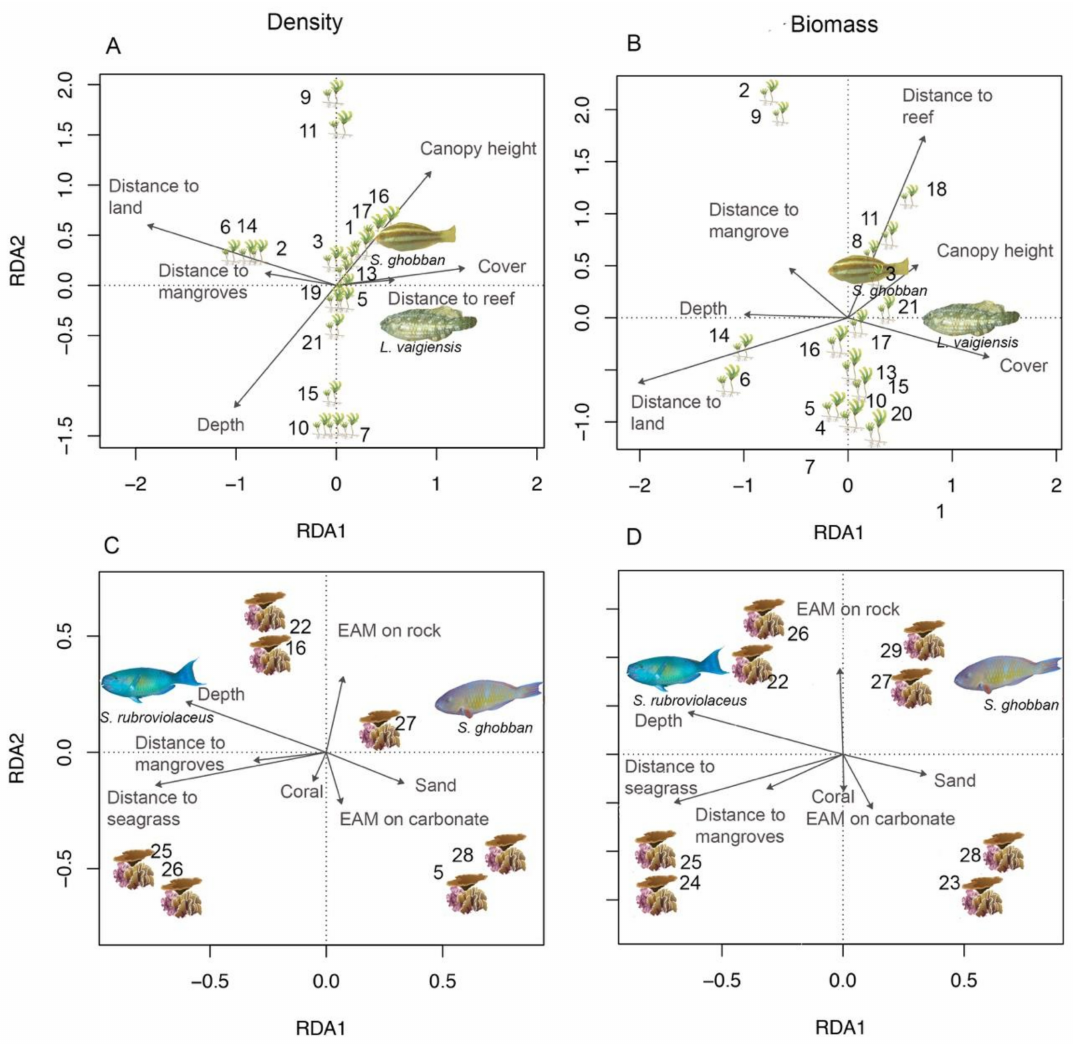
Figure 2. Redundancy ordination plots showing the influence of variables on the density and biomass of three parrotfish species; ( A , B ) in seagrass meadows ( L. vaigiensis and juvenile S. ghobban ) and ( C , D ) on reefs ( S. ghobban and S. rubroviolaceus ). Length of arrow indicate variable strength. The di ff erent survey sites are numbered as in Figure 1. R 2 values ( A ) = 0.583, ( B ) = 0.538, ( C ) = 0.877, ( D ) =